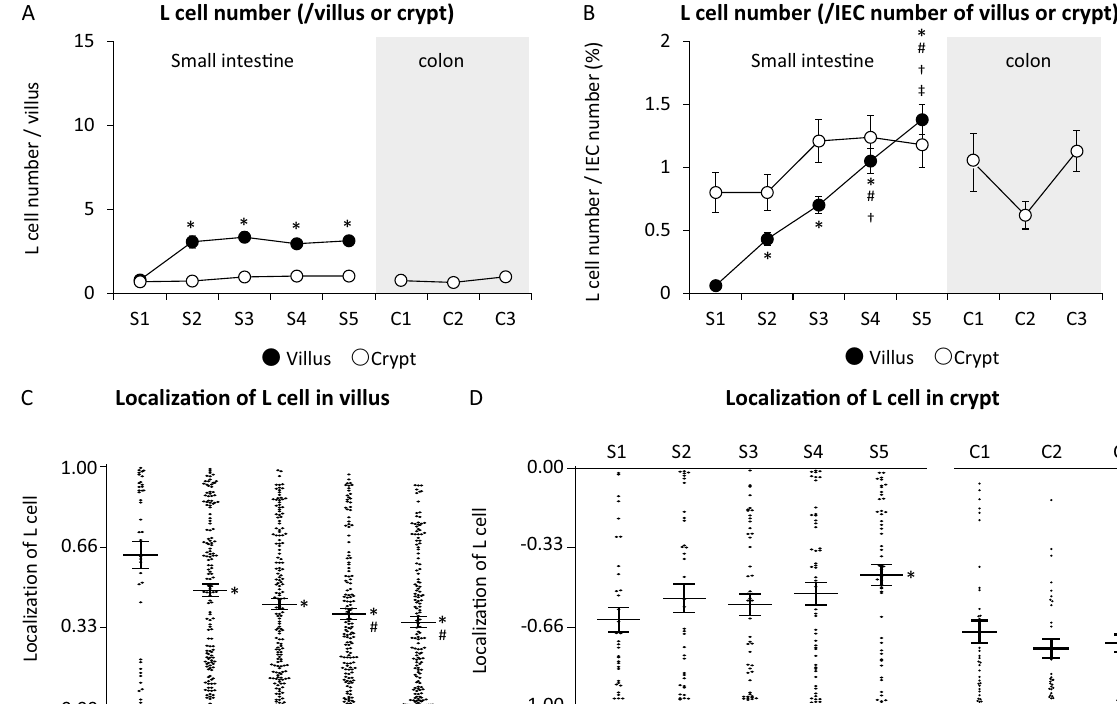
Lower villusMiddle villusUpper villus